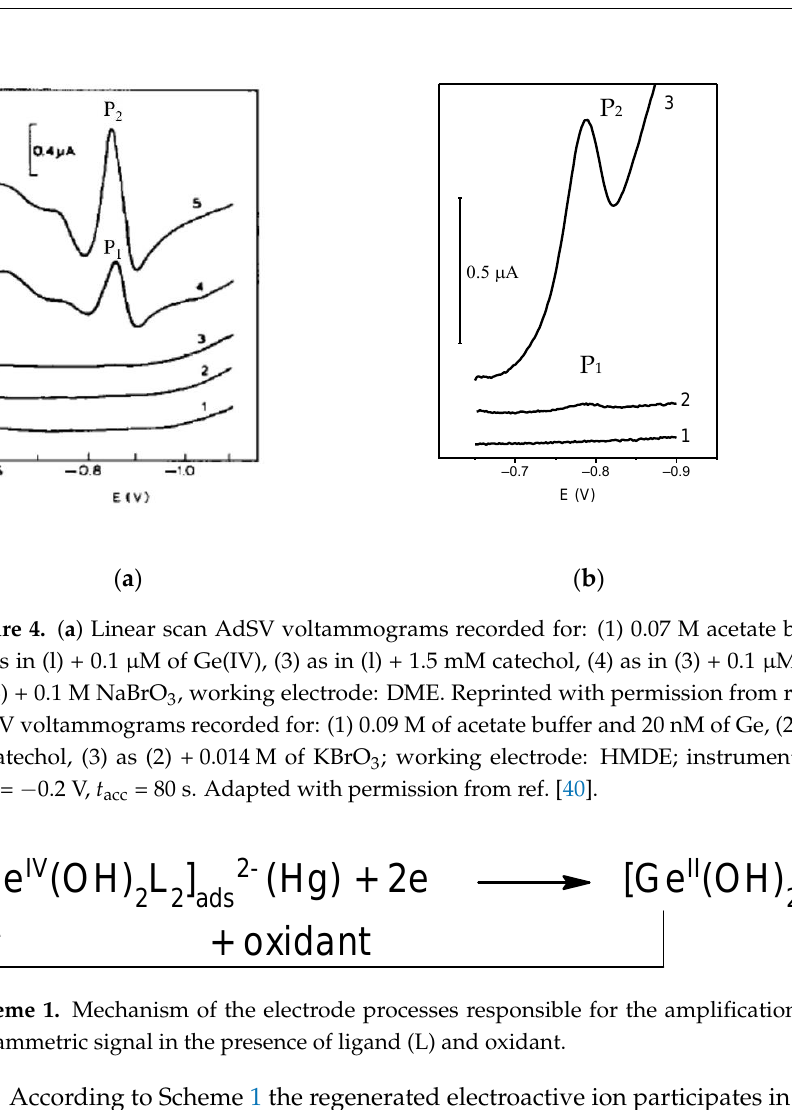
Table 1. Catalytic systems involving germanium and their properties.